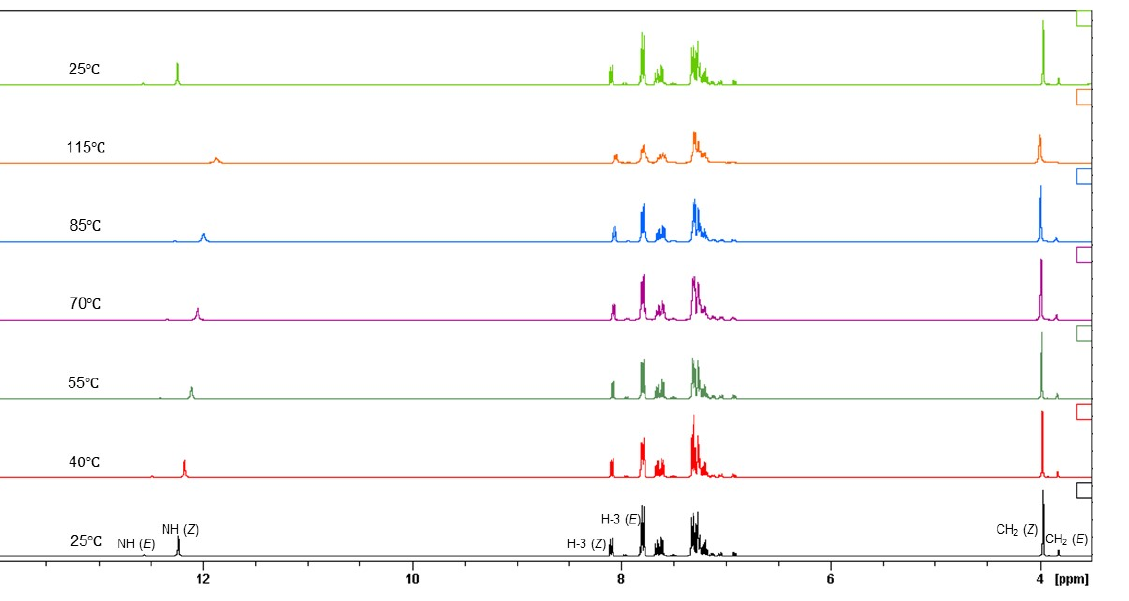
Figure 6. Variable temperature 1 H NMR spectra (DMSO- d 6 , 25–115 ℃ ) of compound 1 (zoom 3.5–14 ppm). Table 2. The Gibbs energy difference between the Z / E conformers ( ∆∆ G ) and their ( Z )/( E ) population ratios obtained from a theoretical two-state model or from the 1 H NMR experiments (only for Compound 1 ) in different solvents at 25 ◦